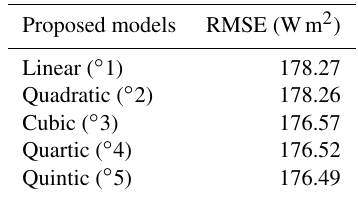
Table 1. Performance evaluation of various polynomial order re- gressors. We measure the RMSE value for each of the